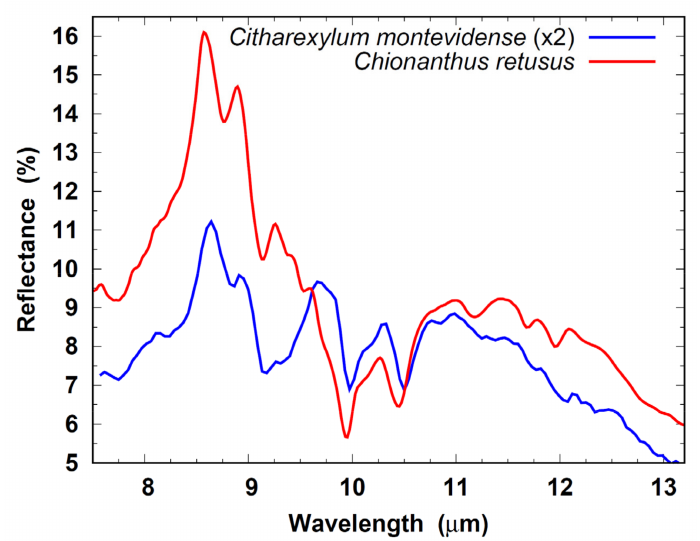
Figure 15. Intercomparison of Chionanthus retusus and Citharexylum montevidense spectra. The C. montevidense library spectrum has been scaled by a factor of 2.